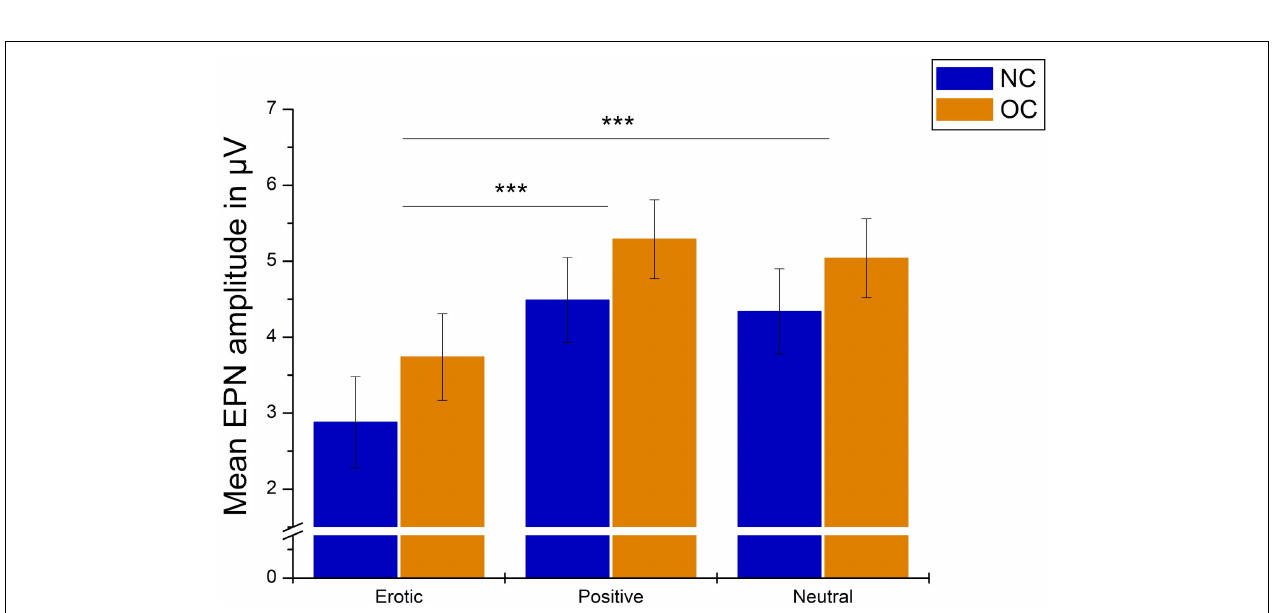
FIGURE 6 | Mean EPN amplitudes in µ V averaged over electrodes PO7, PO8, O1, and O2 in reaction to erotic, positive and neutral stimuli in NC women and OC users. Error bars reflect SEM. *** p < 0.001.